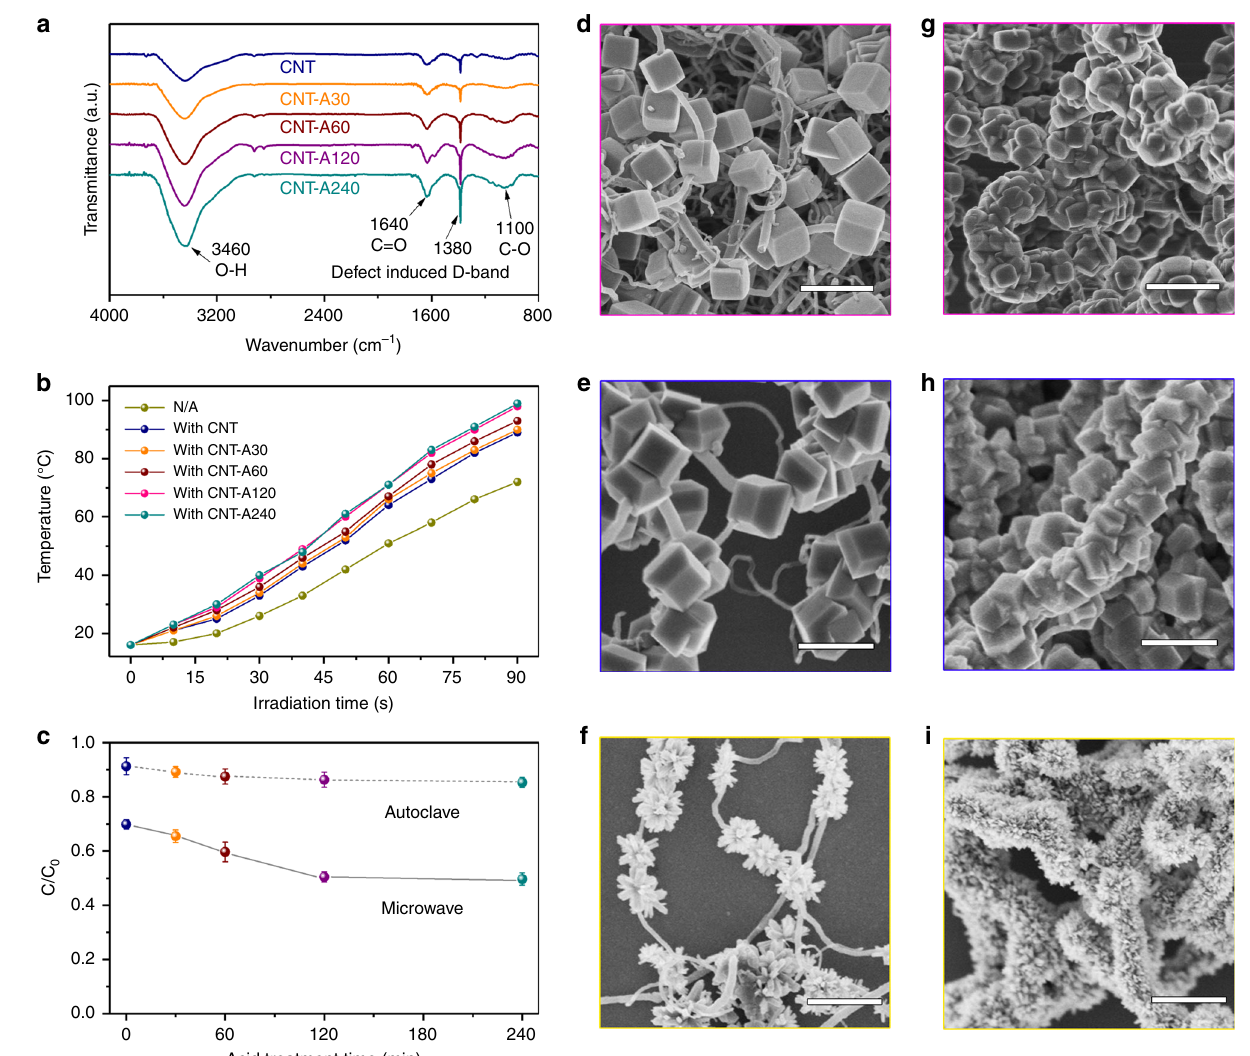
Fig. 5 Surface functional groups affected the microwave antenna performance of CNTs. a FT-IR spectra of CNTs after HNO 3 pre-treatment for 0, 30, 60, 120 and 240 min. b Plots of the temperature of DMSO solution (200 mL) vs. microwave irradiation time in the presence or absence of different CNTs. c CNTs acid pre-treatment time-dependent concentration change of Ti 3 + under microwave irradiation and autoclave hydrothermal heating by keeping the heating temperature of 50 °C for 20 min. d – i FESEM images of ( d , g ) CNT-anatase TiO 2 nanocubes with exposed (001) and (010) facets, ( e , h ) CNT- threaded anatase TiO 2 nanodecahedrons with exposed (001) and (101) facets, and ( f , i ) CNT-threaded rutile TiO 2 nano fl owers by using ( d – f ) untreated and ( g – i ) CNTs pre-treated with HNO 3 for 240 min. Scale bars in d – i : 1 μ